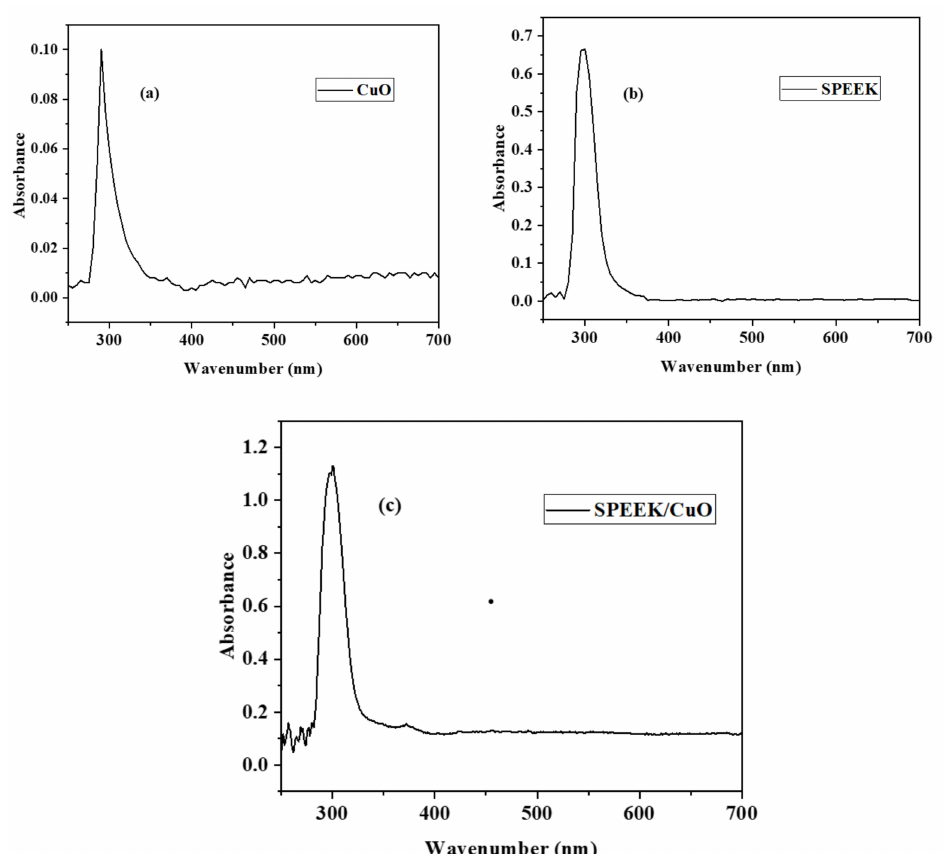
Figure 1. UV–vis spectra of ( a ) CuO NPs, ( b ) SPEEK polymer, and ( c ) SPEEK/CuO NPs nanocom-